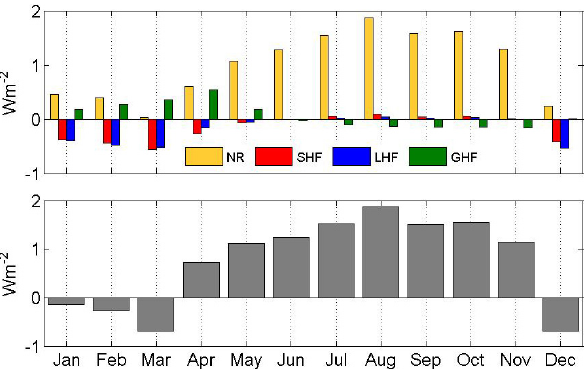
Fig. 7. Upper panel: mean monthly energy balance components NR (net radiation), SHF (sensible heat flux), LHF (latent heat flux), GHF (ground heat flux) and total energy balance ( dE/dt ; lower panel). Positive signs indicate a gain of energy at the